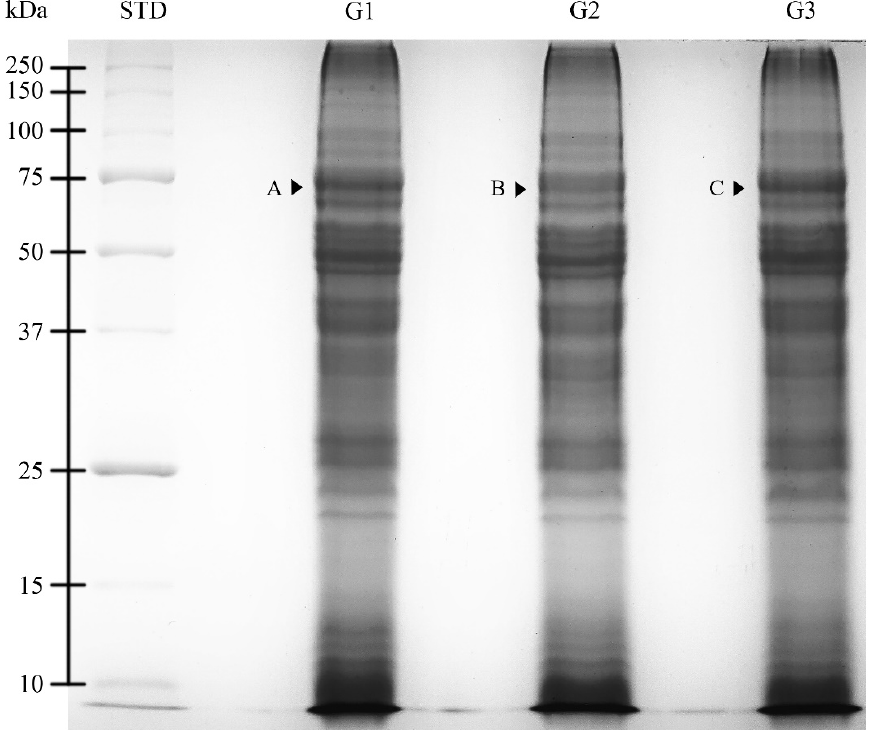
Figure 2. One-dimensional SDS-PAGE (12%) gel image of the cauda epididymal spermatozoa of dogs ( Canis lupus familiaris ) in different age groups (G1: 12–41 months old; G2: 42–77 months old; G3: 78–132 months old). Differentially expressed proteins (DEPs) are marked with letters A, B, and C. STD—molecular weight markers.